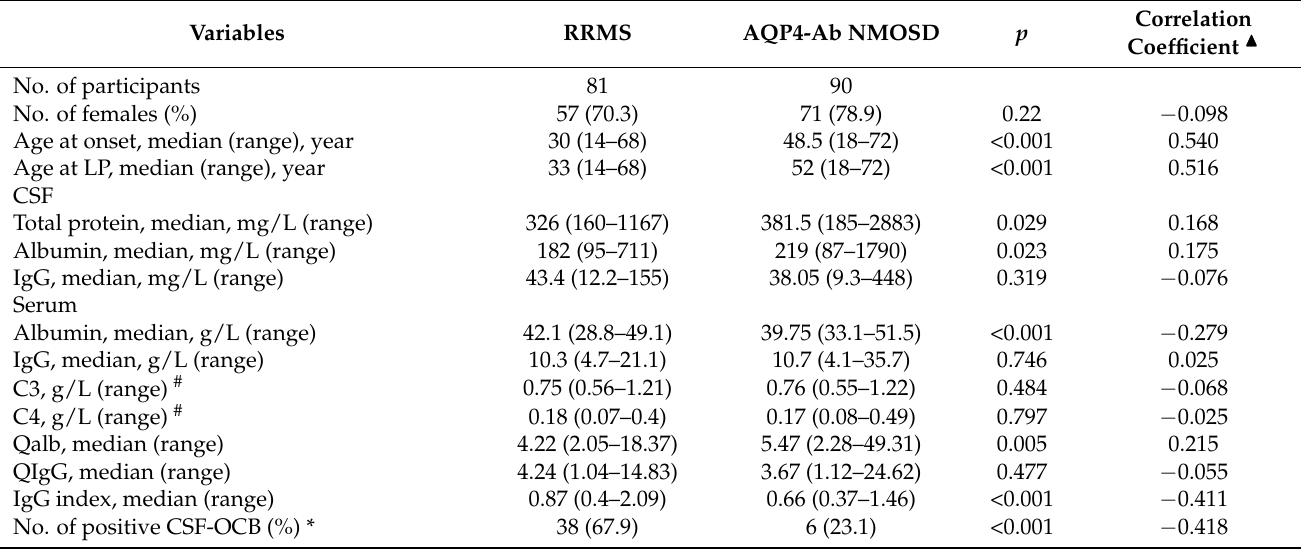
Table 1. Clinical laboratory profiles of the